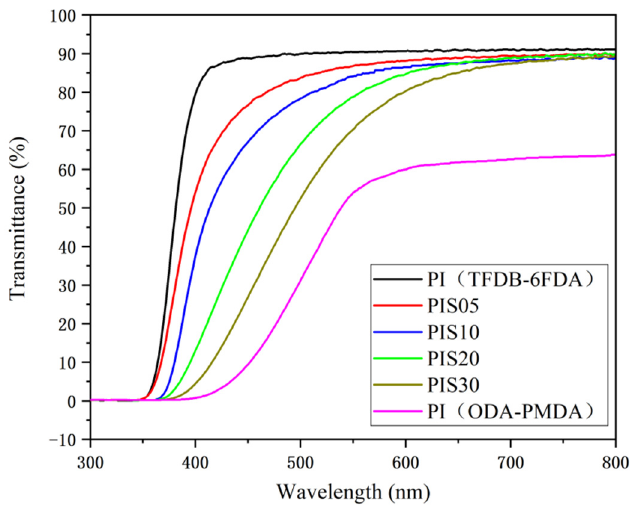
Figure 3. The transmittance of the TFDB-6FDA system PI film, PIS05, PIS10, PIS20, PIS30 and the ODA-PMDA system PI film.